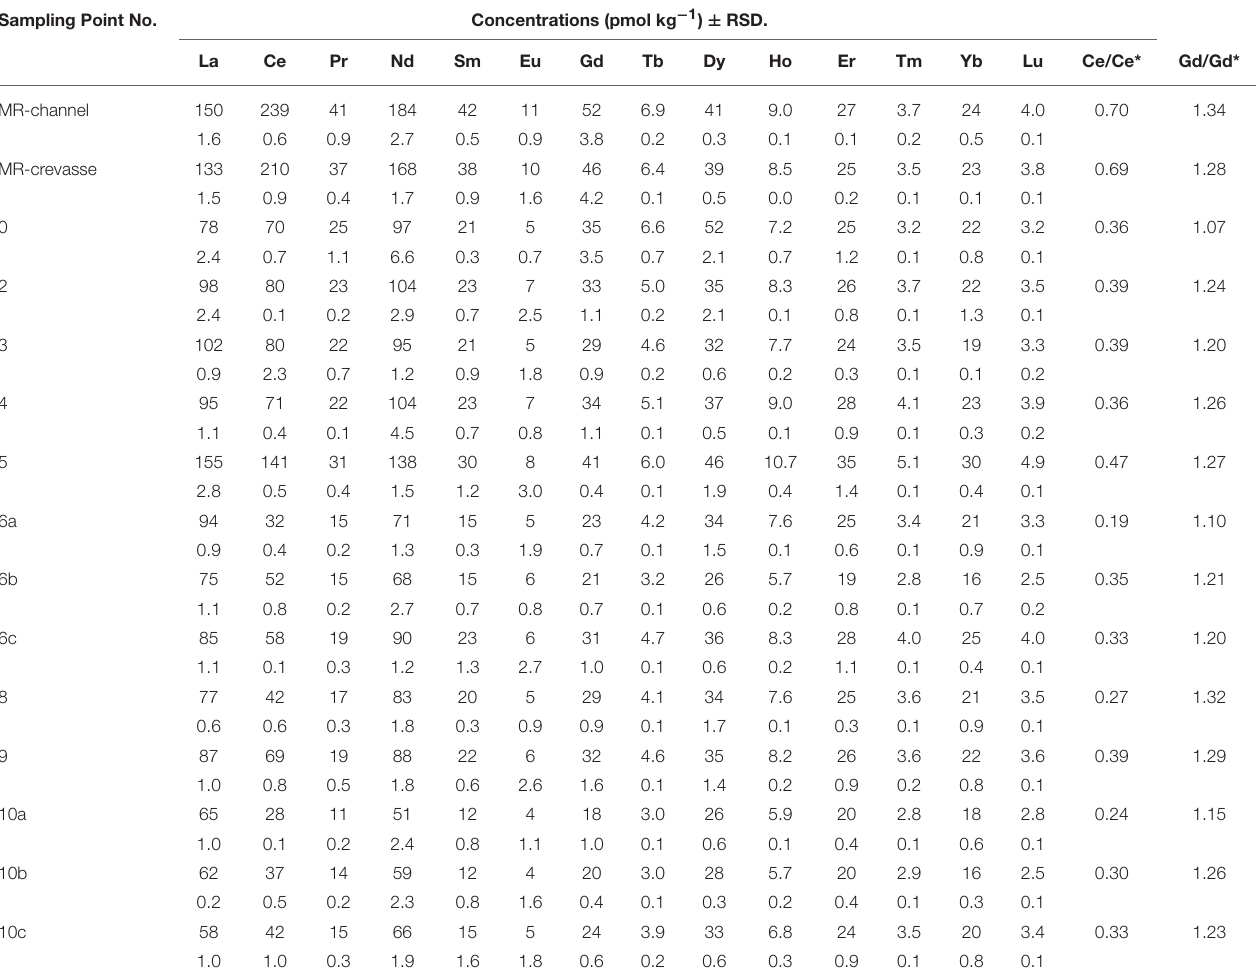
TABLE 3 | The REE concentrations, relative standard deviation (i.e., instrumental precision), and computed Ce and Gd anomalies of samples from the Mississippi River and Louisiana Shelf. Sampling Point No.